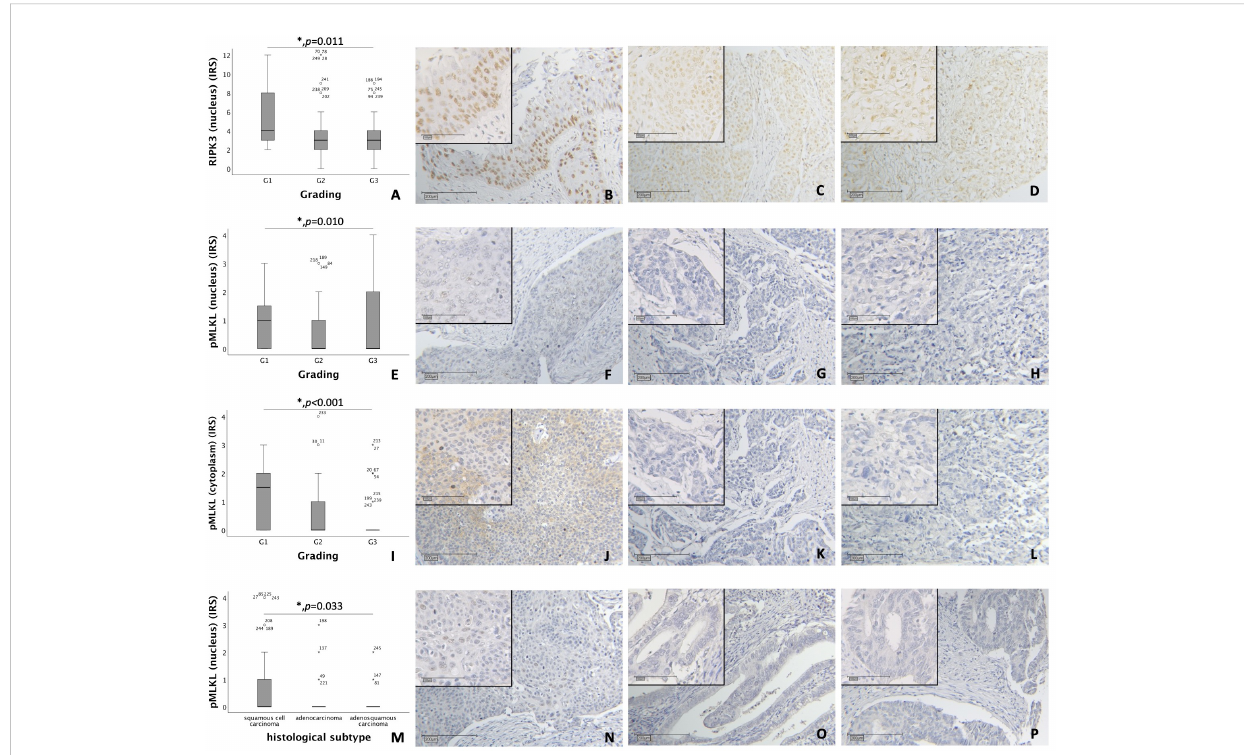
FIGURE 1 (A – D) Correlation of nuclear RIPK3 expression with tumor grading in cervical carcinoma (p = 0.011). (A) boxplot of nuclear RIPK3 expression and tumor grading in cervical carcinoma. (B) cervical carcinoma, grading G1 (n = 18) with a nuclear RIPK3 IRS of 6, magni fi cation x10 and x25 in the inset. (C) cervical carcinoma, grading G2 (n = 131) with a nuclear RIPK3 IRS of 3, magni fi cation x10 and x25 in the inset. (D) cervical carcinoma, grading G3 (n = 74) with a nuclear RIPK3 IRS of 3, magni fi cation x10 and x25 in the inset. (E – H) Correlation of nuclear pMLKL expression with tumor grading in cervical carcinoma (p = 0.010). (E) boxplot of nuclear pMLKL expression and tumor grading in cervical carcinoma. (F) cervical carcinoma, grading G1 (n = 16) with a nuclear pMLKL IRS of 3, magni fi cation x10 and x25 in the inset. (G) cervical carcinoma, grading G2 (n = 119) with a nuclear pMLKL IRS of 0, magni fi cation x10 and x25 in the inset. (H) cervical carcinoma, grading G3 (n = 72) with a nuclear pMLKL IRS of 0, magni fi cation x10 and x25 in the inset. (I – L) Correlation of cytoplasmic pMLKL expression with tumor grading in cervical carcinoma (p < 0.001). (I) boxplot of cytoplasmic pMLKL expression and tumor grading in cervical carcinoma. (J) cervical carcinoma, grading G1 (n = 16) with a cytoplasmic pMLKL IRS of 3, magni fi cation x10 and x25 in the inset. (K) cervical carcinoma, grading G2 (n = 119) with a cytoplasmic pMLKL IRS of 0, magni fi cation x10 and x25 in the inset. (L) cervical carcinoma, grading G3 (n = 72) with a cytoplasmic pMLKL IRS of 0, magni fi cation x10 and x25 in the inset. (M – P) Correlation of nuclear pMLKL expression with histological subtype in cervical carcinoma (p = 0.033). (M) boxplot of nuclear pMLKL expression and histological subtype in cervical carcinoma. (N) cervical squamous cell carcinoma (n = 169) with a nuclear pMLKL IRS of 2, magni fi cation x10 and x25 in the inset. (O) cervical adenocarcinoma (n = 23) with a nuclear pMLKL IRS of 0, magni fi cation x10 and x25 in the inset. (P) cervical adenosquamous